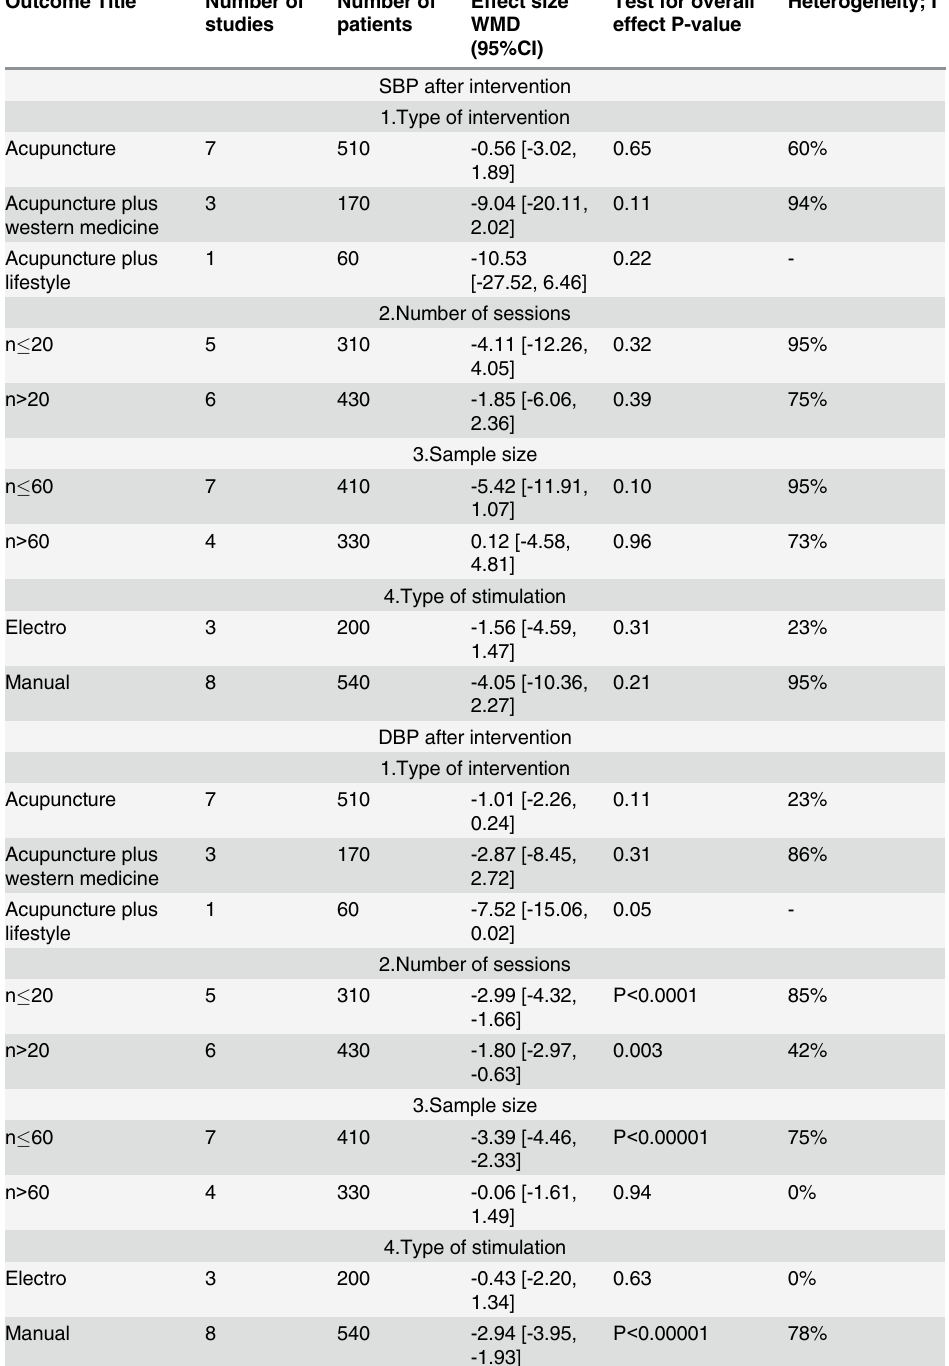
Table 2. Subgroup analysis and investigation of heterogeneity on SBP/DBP after